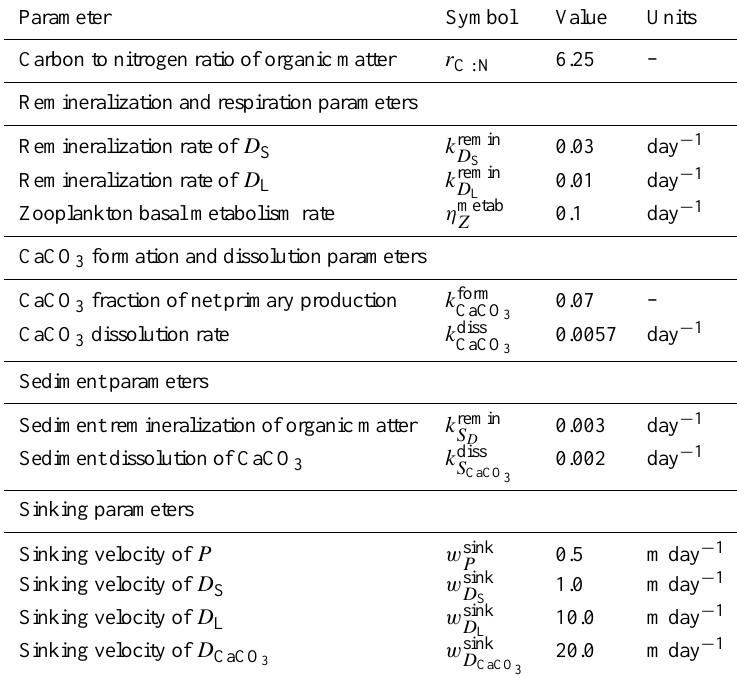
Table A1. Summary of the definitions, symbols, values and units of the parameters used in the carbon module of the ecological- biogeochemical